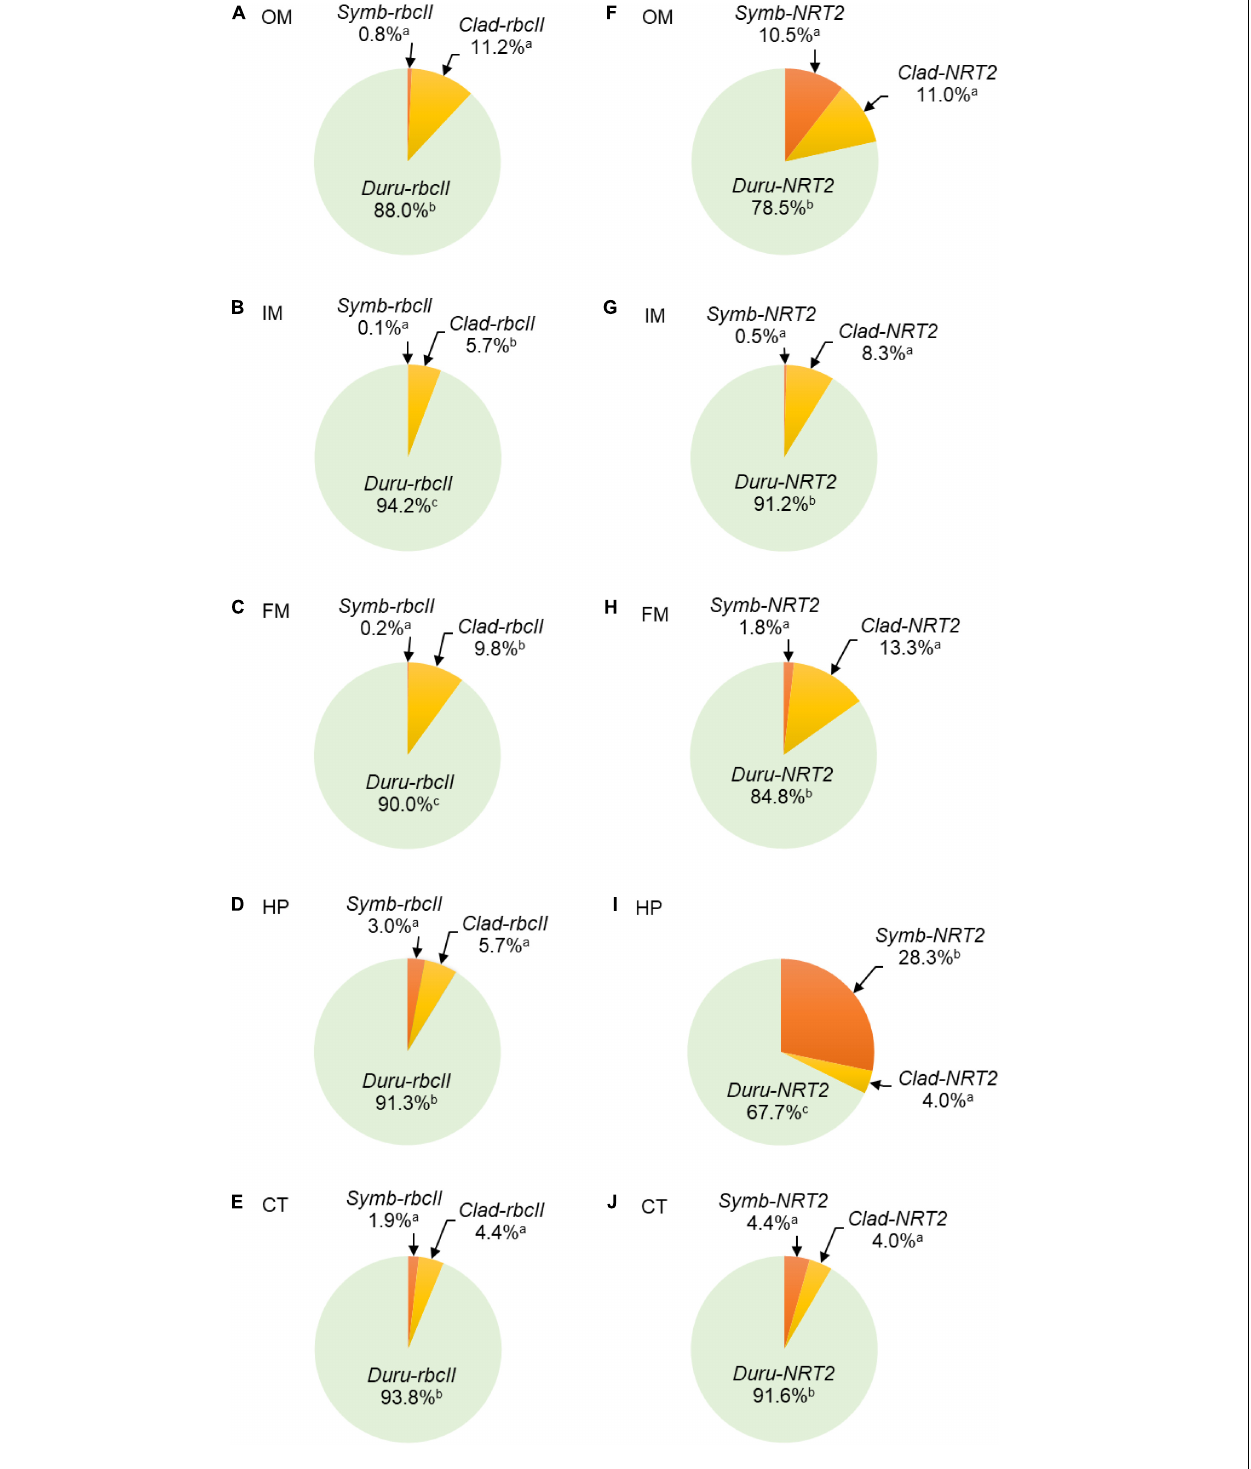
FIGURE 4 | Proportion of transcript levels of form II ribulose-1,5-bisphosphate carboxylase/oxygenase (rbcII) or transcript levels of nitrate transporter 2 (NRT2) derived from Symbiodinium ( Symb-rbcII and Symb-NRT2, respectively), Cladocopium ( Clad-rbcII and Clad-NRT2 , respectively) and Durusdinium ( Duru-rbcII and Duru-NRT2 , respectively) in five organs of Tridacna squamosa . Results ( n = 13) are expressed as mean percentages in (A,F) the outer mantle (OM), (B,G) the inner mantle (IM), (C,H) the foot muscle (FM), (D,I) the hepatopancreas (HP), and (E,J) the ctenidium (CT). Means that are significantly different from each other are labeled with different letters ( p -value < 0.017 after Bonferroni